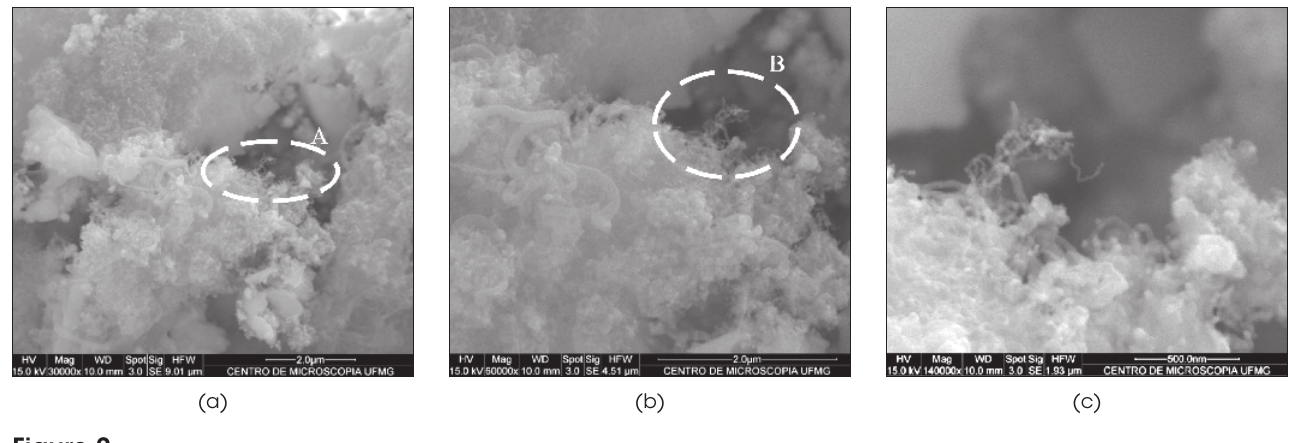
Scanning electron microscopy images of CNTs grown directly on the cement clinker